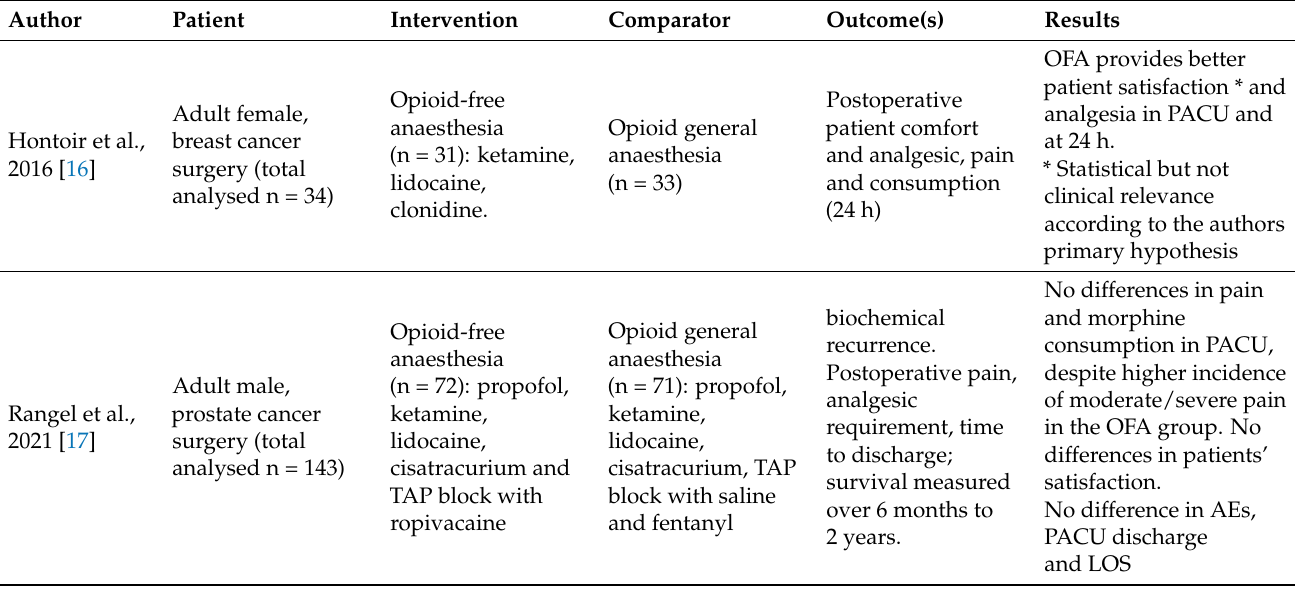
Table 1. Characteristics of the two studies included after systematic literature search. OFA: Opioid- Free Anesthesia; PACU: Post-Anesthetic Care Unit; AEs: Adverse Events; LOS: Length of Stay.